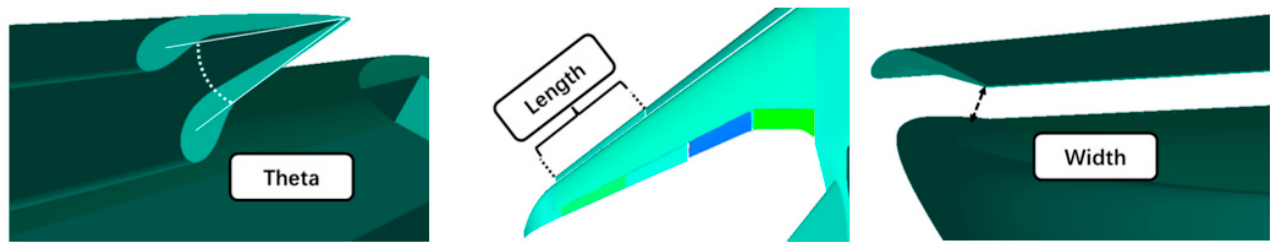
Figure 27. Adjustment parameters of the Krueger flap for the improvement of aileron surface flow